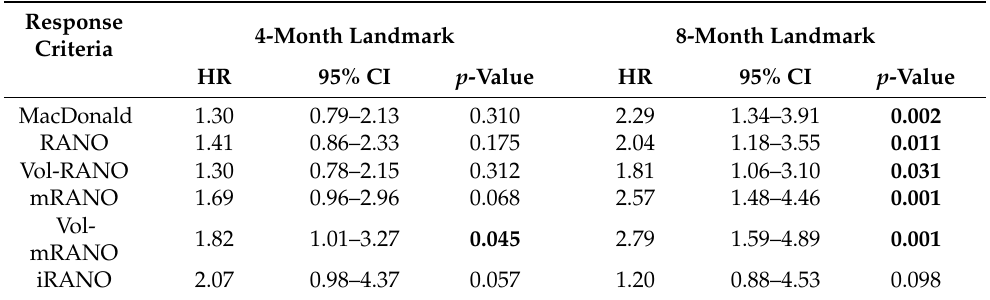
Table 5. Hazard ratios with corresponding confidence interval for patients with progressive disease at the 4- and 8-month landmark time.